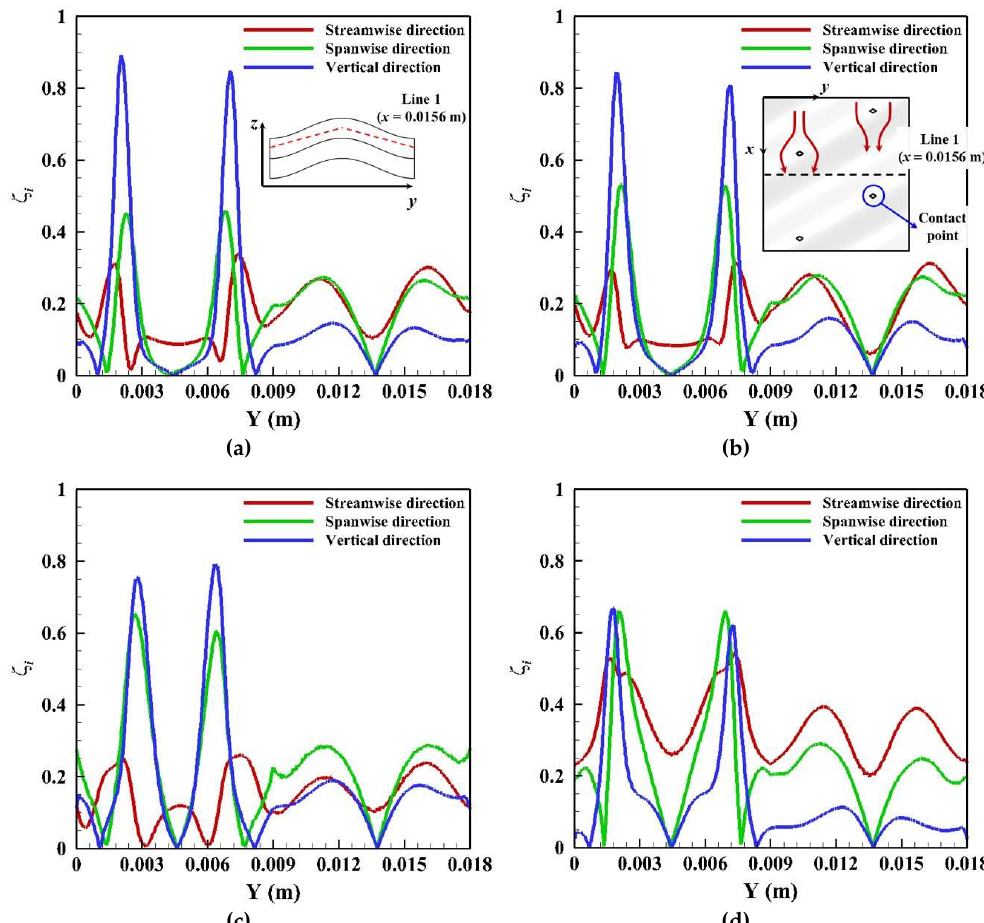
Figure 10. Normalized vorticity distribution with respect to corrugation profiles for each flow direction along Line 1 for ( a ) sinusoidal, ( b ) trapezoidal, ( c ) triangular, and ( d ) elliptical corrugation profiles.